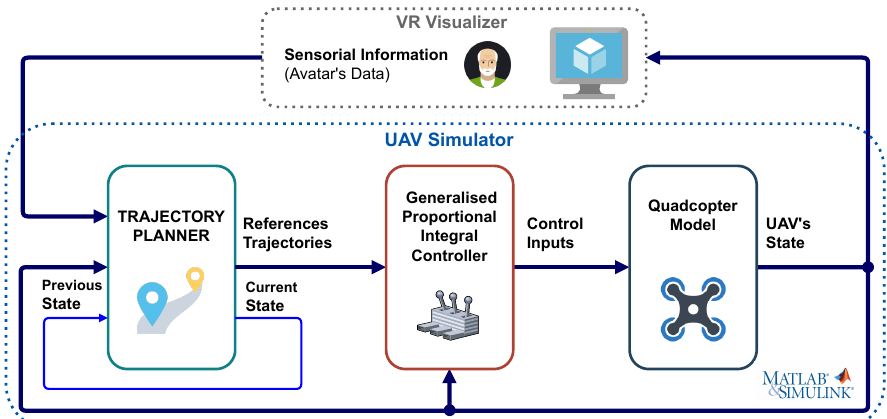
Figure 3. General diagram of the UAV s imulator which receives from the VR visualiser the infor- mation concerning the person’s avatar to calculate the reference trajectories used by the controller to guide the UAV in the monitoring process while returns the aircraft’s position and orientation to represent its flight in a virtual home